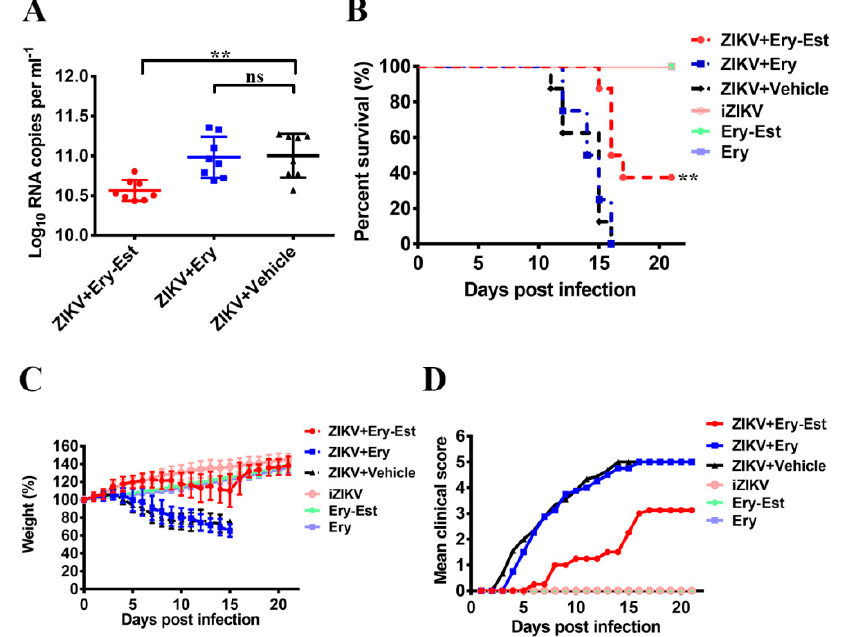
Figure 4. Protective activity of Ery-Est against ZIKV infection in lethal mouse models. Three groups of A129 mice were infected with 1 × 10 5 plaque forming units (PFU) ZIKV, followed by treatment of Ery-Est, Ery, and vehicle at 50 mg / kg respectively ( n = 8). Mice administrated with heat-inactivated ZIKV (iZIKV) or only administrated with Ery-Est and Ery were used as mock controls. ( A ) Viral RNA load in sera of A129 mice 2 dpi, mice were retro-orbitally bled to measure the RNA load by RT-qPCR. ( B ) Survival status, ( C ) body weight, and ( D ) clinical score were recorded every day until 21 dpi. Data are presented as means ± SD for ( A ) and ( C ). Statistical analysis: Mann–Whitney test for ( A ); Log-rank (Mantel Cox) for ( B ). ns = not significant. ** p <